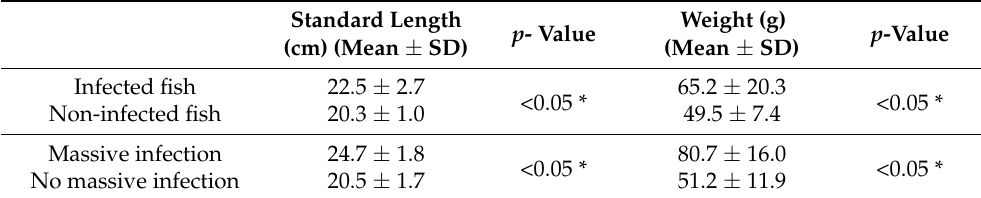
Table 2. Standard length (cm) and weight (g) of infected and non-infected fish (A and B, respectively), and fish with massive infection and without massive infection (C and D, respectively). The data are presented as mean ± SD. * p -value < 0.05 was considered significant.